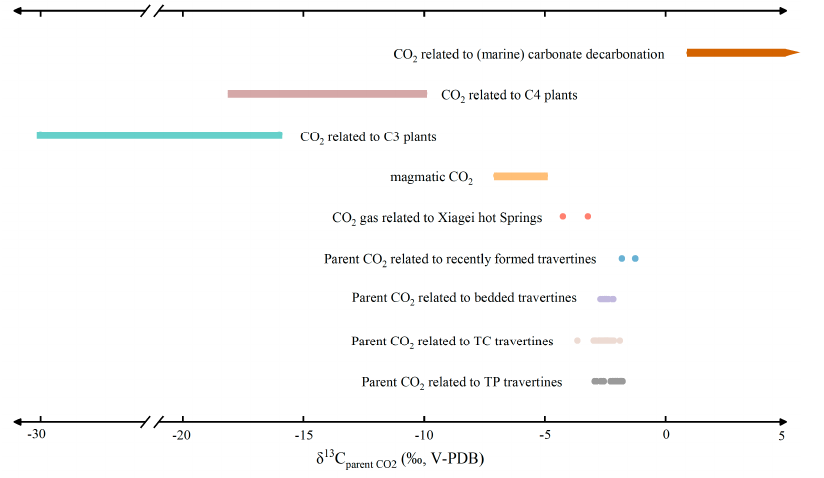
Figure 6. δ 13 C parent CO2 of the travertines from Xiagei, Shangri-La, China, according to the equation established by Chacko et al. [40]. In comparison with the δ 13 C values from CO 2 gas related to Xiagei hot springs [53], magmatic CO 2 [50], CO 2 related to C3 and C4 plants [48,49], and marine carbonate decarbonation [43,51]. TP: thick-laminated crystalline crust; TC: thin-laminated composite crystalline crust.